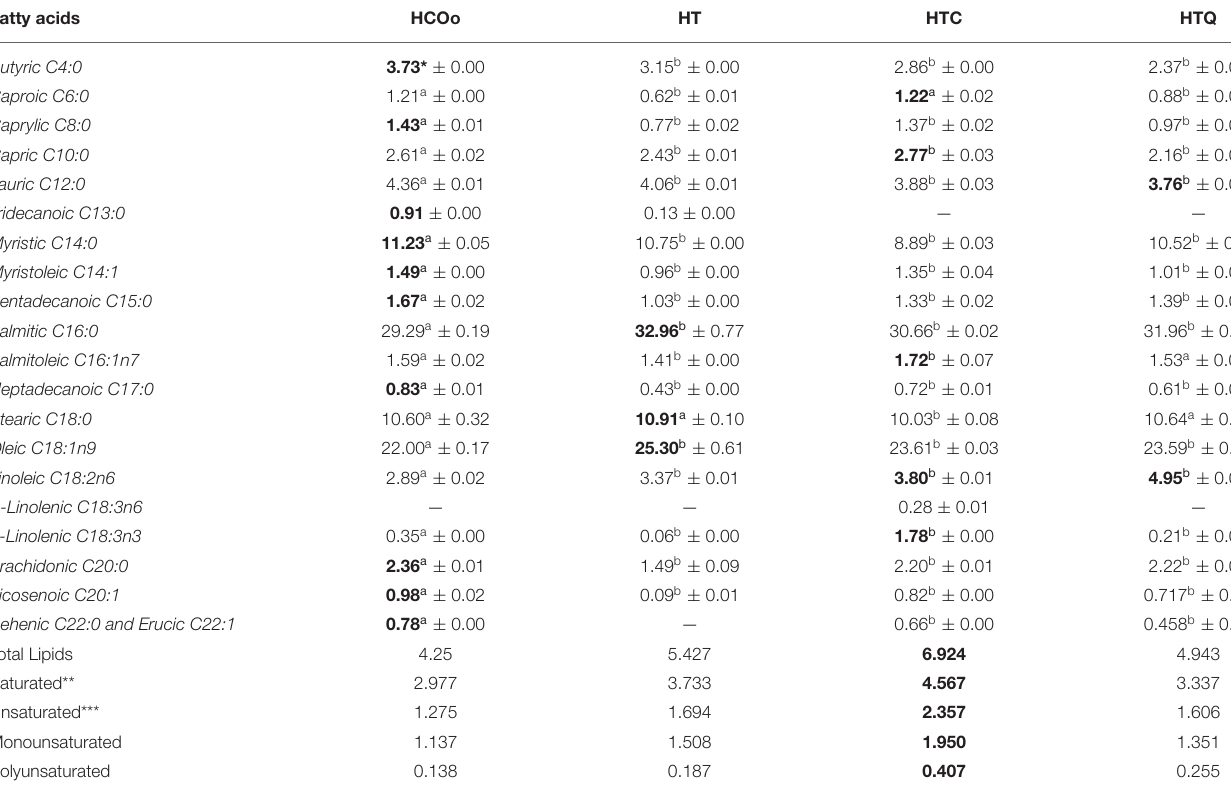
TABLE 2 | Results of the types of fatty acids in each formulation manufactured (g FA/100g of fresh sample). Fatty acids